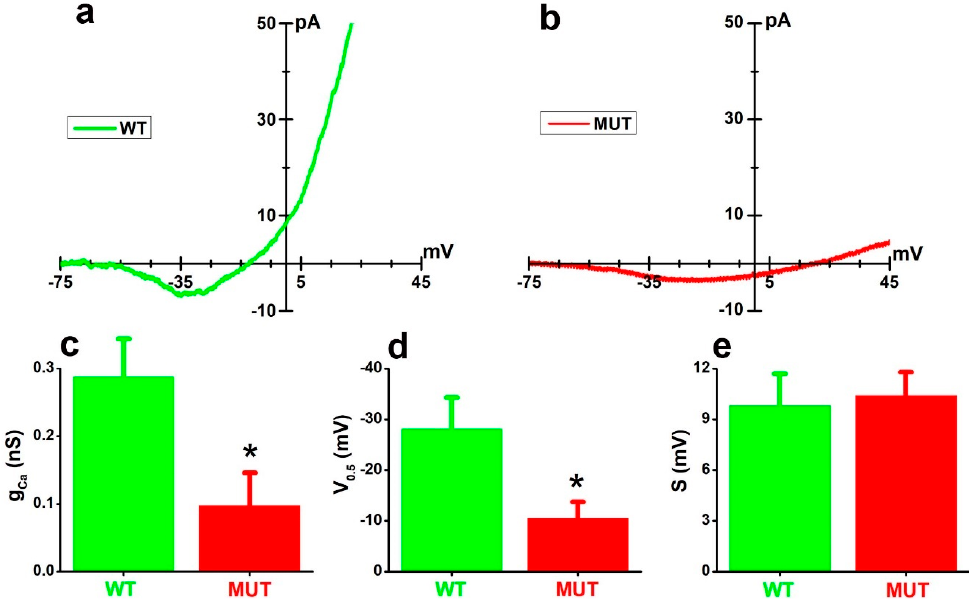
Figure 1. ( a , b ) Traces plot average of nine sweeps evoked by voltage ramps in either WT ( a ) or MUT ( b ) rods bathed in TEA-Ba-Cs solution (see Table 1). ( c – e ) Bars plot average values (+SEM) for maximal conductance (g Ca ) ( c ), half-activation voltages (V 0.5 ) ( d ), and inverse slope factors (S) ( e ) for five WT (green) and five MUT (red) rods. * p < 0.05 by two-tailed t -test (( c ), t = 2.57522, 8 df: p = 0.03286) (( d ), t = 2.54231, 8 df: p = 0.03459). Table 1. The pH was buffered to 7.4 with NaOH 1N for Locke’s and TEA-Ba-Cs solutions and 7.2 with KOH 1N for intracellular saline. Osmolarity was close to 300 mOsm/l for all solutions. SALINE